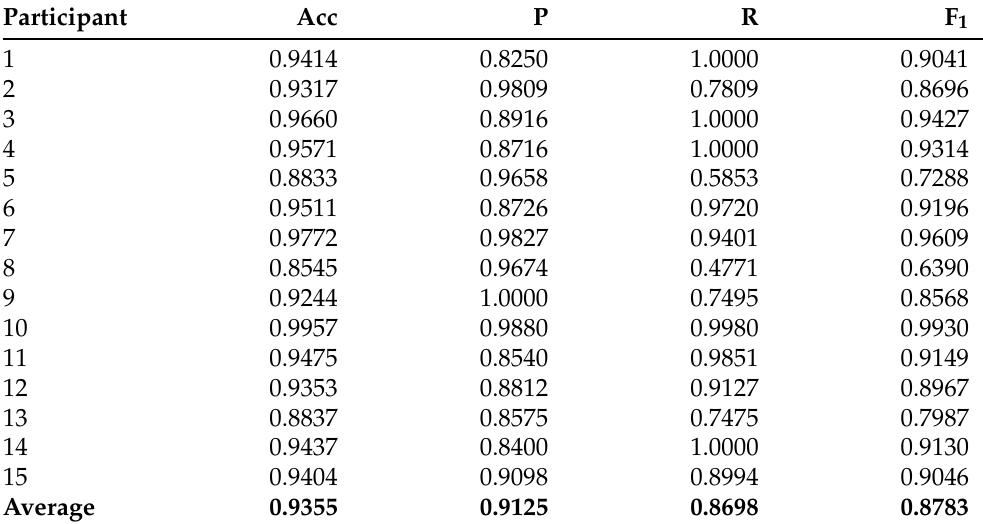
Table 5. Centralized Learning Result.